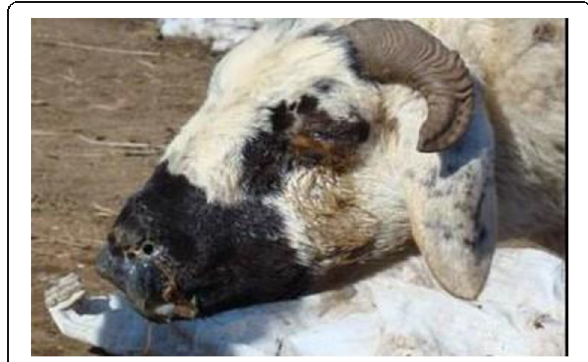
Fig. 2 Thick discharges from the nose, nostrils and eyes. Source: (Mirzaie et al. 2015)